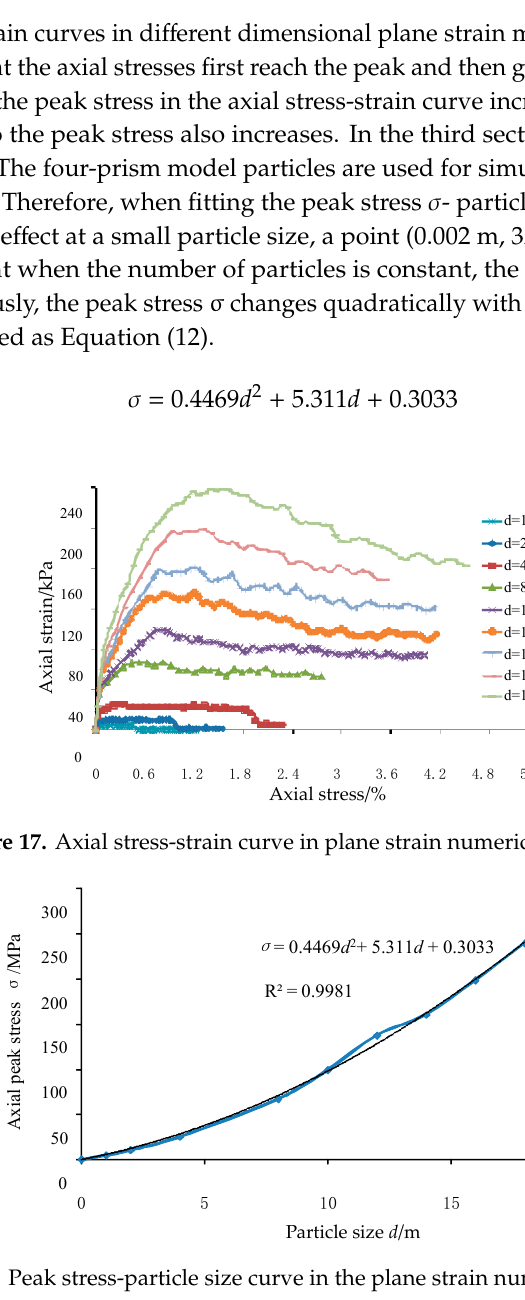
Figure 18. Peak stress-particle size curve in the plane strain numerical analysis.